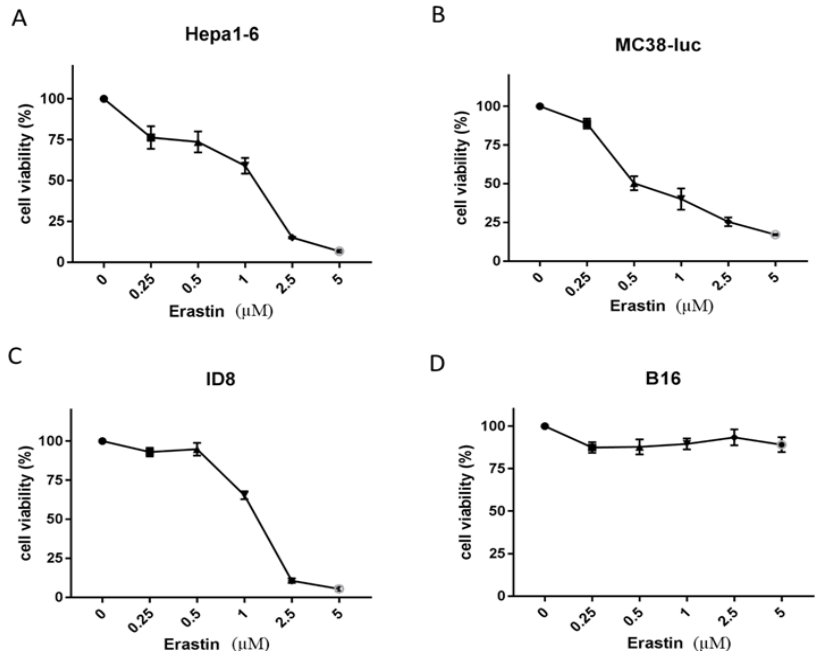
Figure 1. Erastin exhibits different cell toxicities on different cancer cell lines. Hepa1-6 (1.0 × 10 4 cells) ( A ), MC38-luc (1.0 × 10 4 cells) ( B ), ID8 (5.0 × 10 3 cells) ( C ), and B16 (5.0 × 10 3 cells) ( D ) were plated per well in 96-well plates and cocultured with different concentrations of erastin the next day as indicated. Cell viability was measured after treatment for 24 h using MTS assay. Data are presented as mean ± SD.